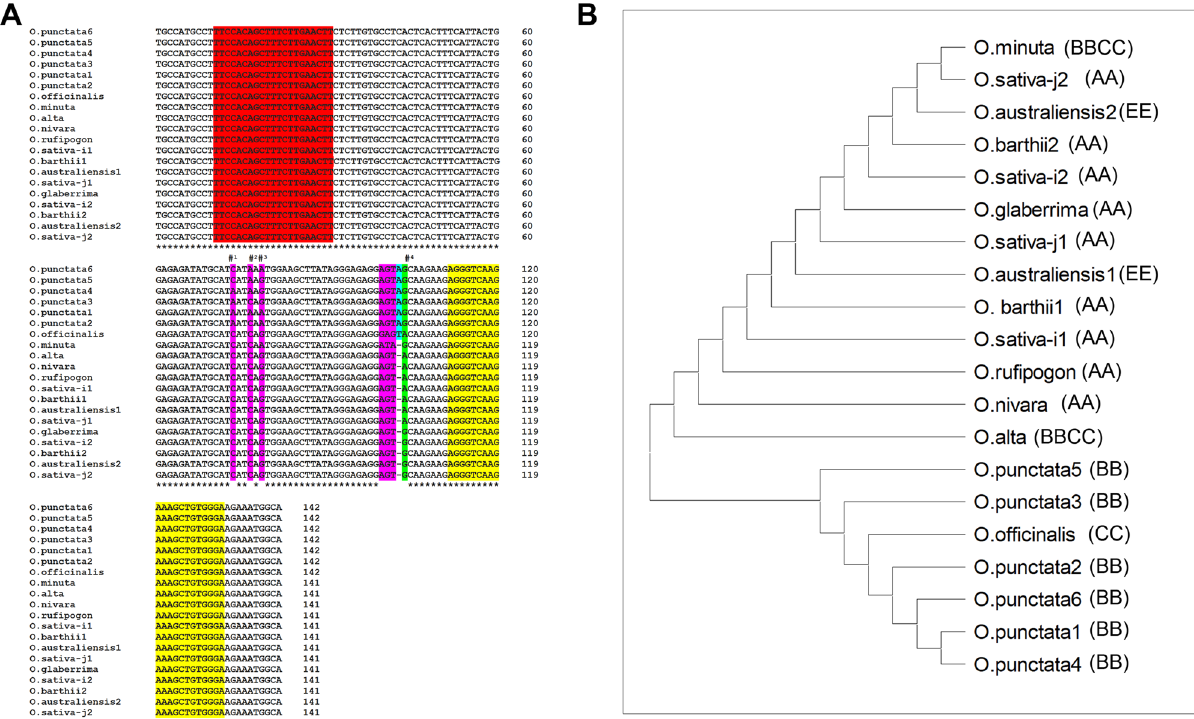
Figure 1. Multiple Sequence alignment (MSA) and phylogenetic analysis of pre- miR396c in Oryza species. For eleven Oryza species, a high degree of conservation of the pre- miR396c sequence was observed. ( A ) : Alignment of pre- miR396c sequences from Oryza species. Conservation of miRNA (Red) and miRNA* (Yellow) sequences are indicated. Seven SNPs and one indel were identified between miRNA and miRNA* regions and bases are highlighted in pink or green. Of these, residues marked # 1 -# 3 were heterozygous in O. punctata (listed as O.punctata1-6 for ease of representation) and # 4 heterozygous in O. sativa (japonica as Osj1/Osj2), O. sativa ( indica as Osi1/Osi2), O. australiensis (as O.australiensis1/ O.australiensis1) and O. barthii (as O.barthii1/O. barthii2). A single base pair insertion at the same position was observed in pre- miR396c sequences of both O. punctata and O. officinalis (highlighted in blue). ( B ) : Optimal Neighbour-joining tree generated using MSA data (MEGA11). Evolutionary distances were computed using the Maximum Composite Likelihood method, represented as the number of base substitutions per site. The genome type for each Oryza species is indicated within of both O. punctata and O. officinalis . Halophytic wild rice O. coarctata pre- miR396c sequence is significantly different from O. sativa pre- miR396c and shows six base changes in the miRNA-miRNA* region (three each in miRNA and miRNA* regions; Supplementary Fig. 2). The pre- miR396c sequences from eleven Oryza species are 141–142 bp in length while for O. coarctata the pre- miR396c sequence is substantially reduced (133 bp). This 9 bp deletion falls within the intervening miRNA-miRNA* region. The O. coarctata pre- miR396c sequence reported here is identical to that present in the O. coarctata genome 21 (Supplementary Fig. 2), suggesting miR396c func- tion in halophytic wild rice may be significantly different.